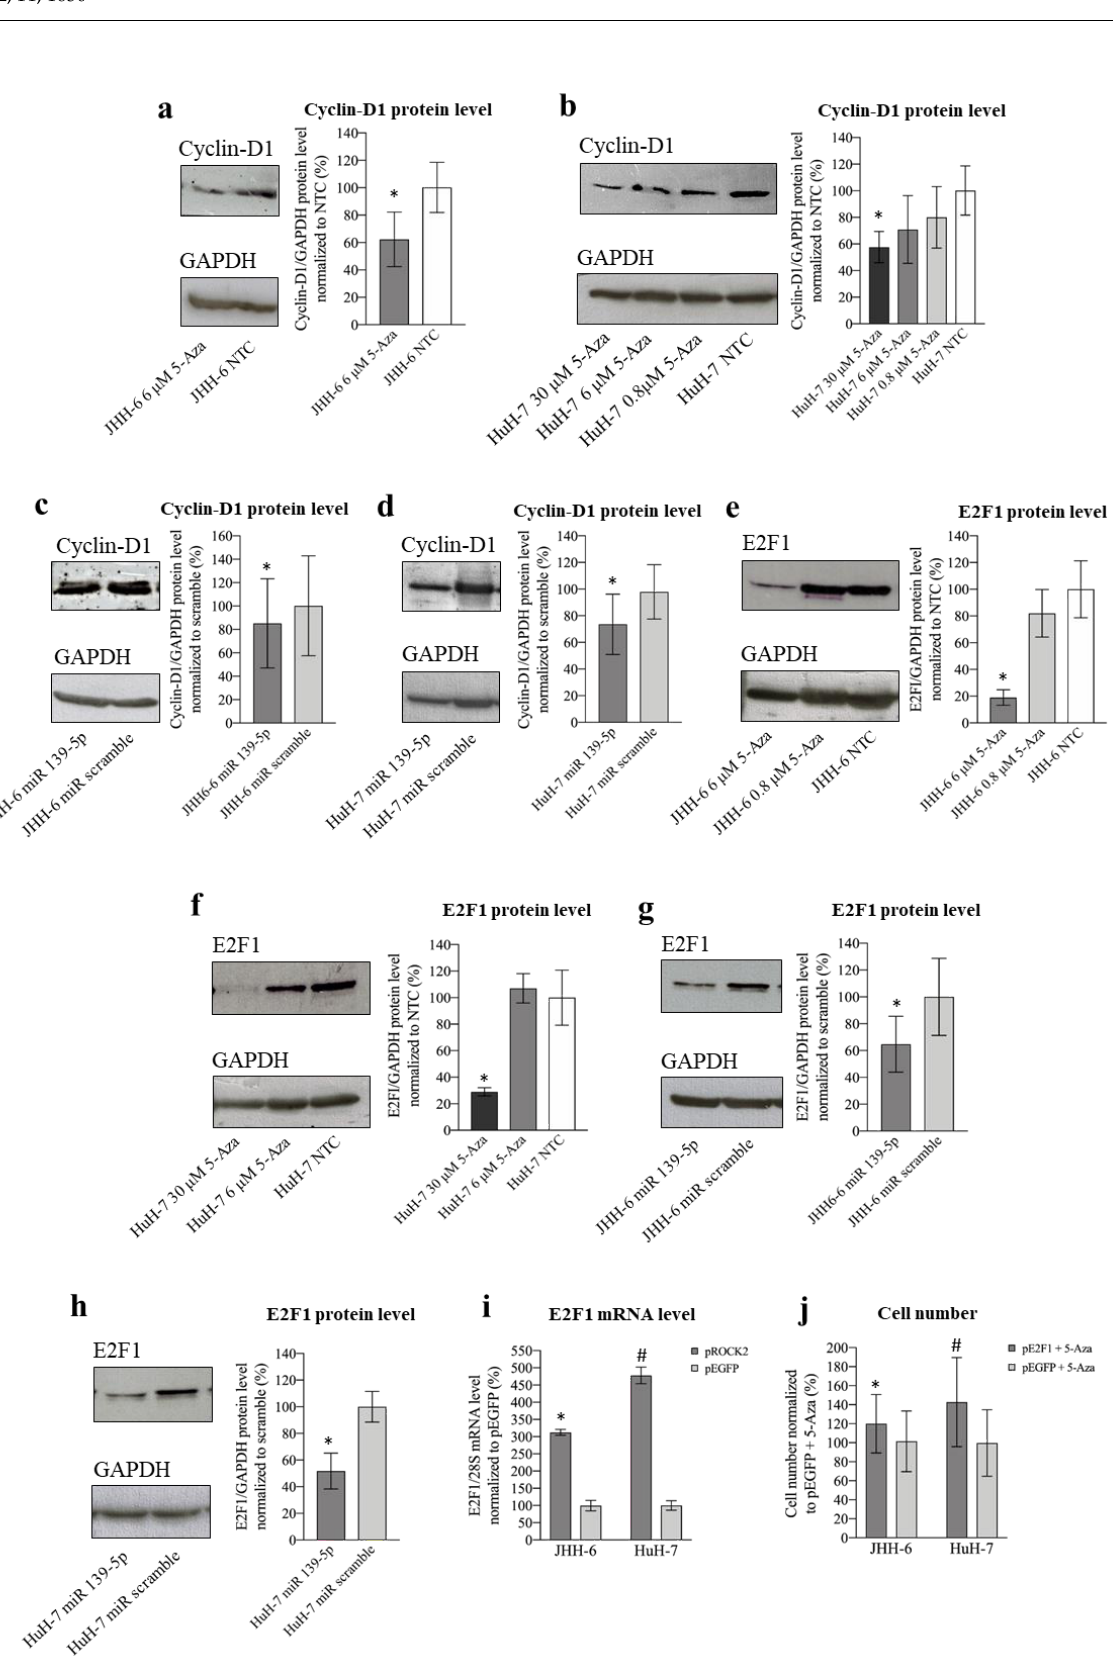
Figure 6. Effects of 5-Aza and miR-139-5p on cyclin D1 and E2F1 expression. ( a ) Effects of 5-Aza on cyclin D1 protein level in JHH-6. Left, representative Western blot (GAPDH was introduced for normalization); right, data normalized to GAPDH levels and to the average of non-treated cells (NTC) are reported in % as mean ± SEM, n = 5; NTC vs./6 μ M, * p = 0.0005. ( b ) Effects of 5-Aza on